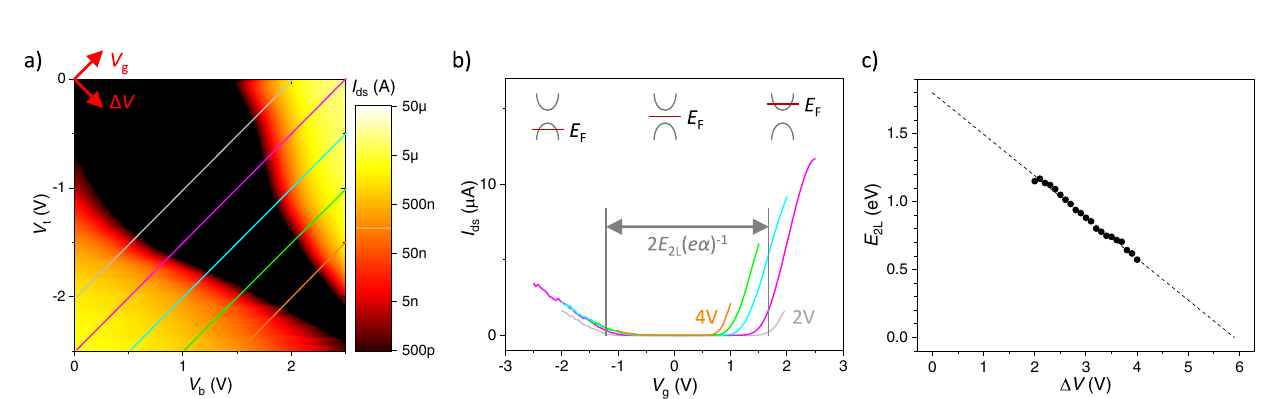
between threshold voltages, indicated for the gray curve ( α isthe gating ef fi ciency and e is the elementarycharge).The bandgapshrinks withincreasing Δ V .Cartoons indicate the position of the Fermi level at different V g . c Measured values of E 2L vs. Δ V extracted from the line scans as well as a linear fi t (dashed line).